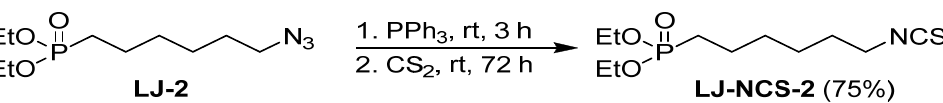
Figure 3. Microwave-assisted synthesis of LJ-NCS-3 using DMT/NMM/TsO − .